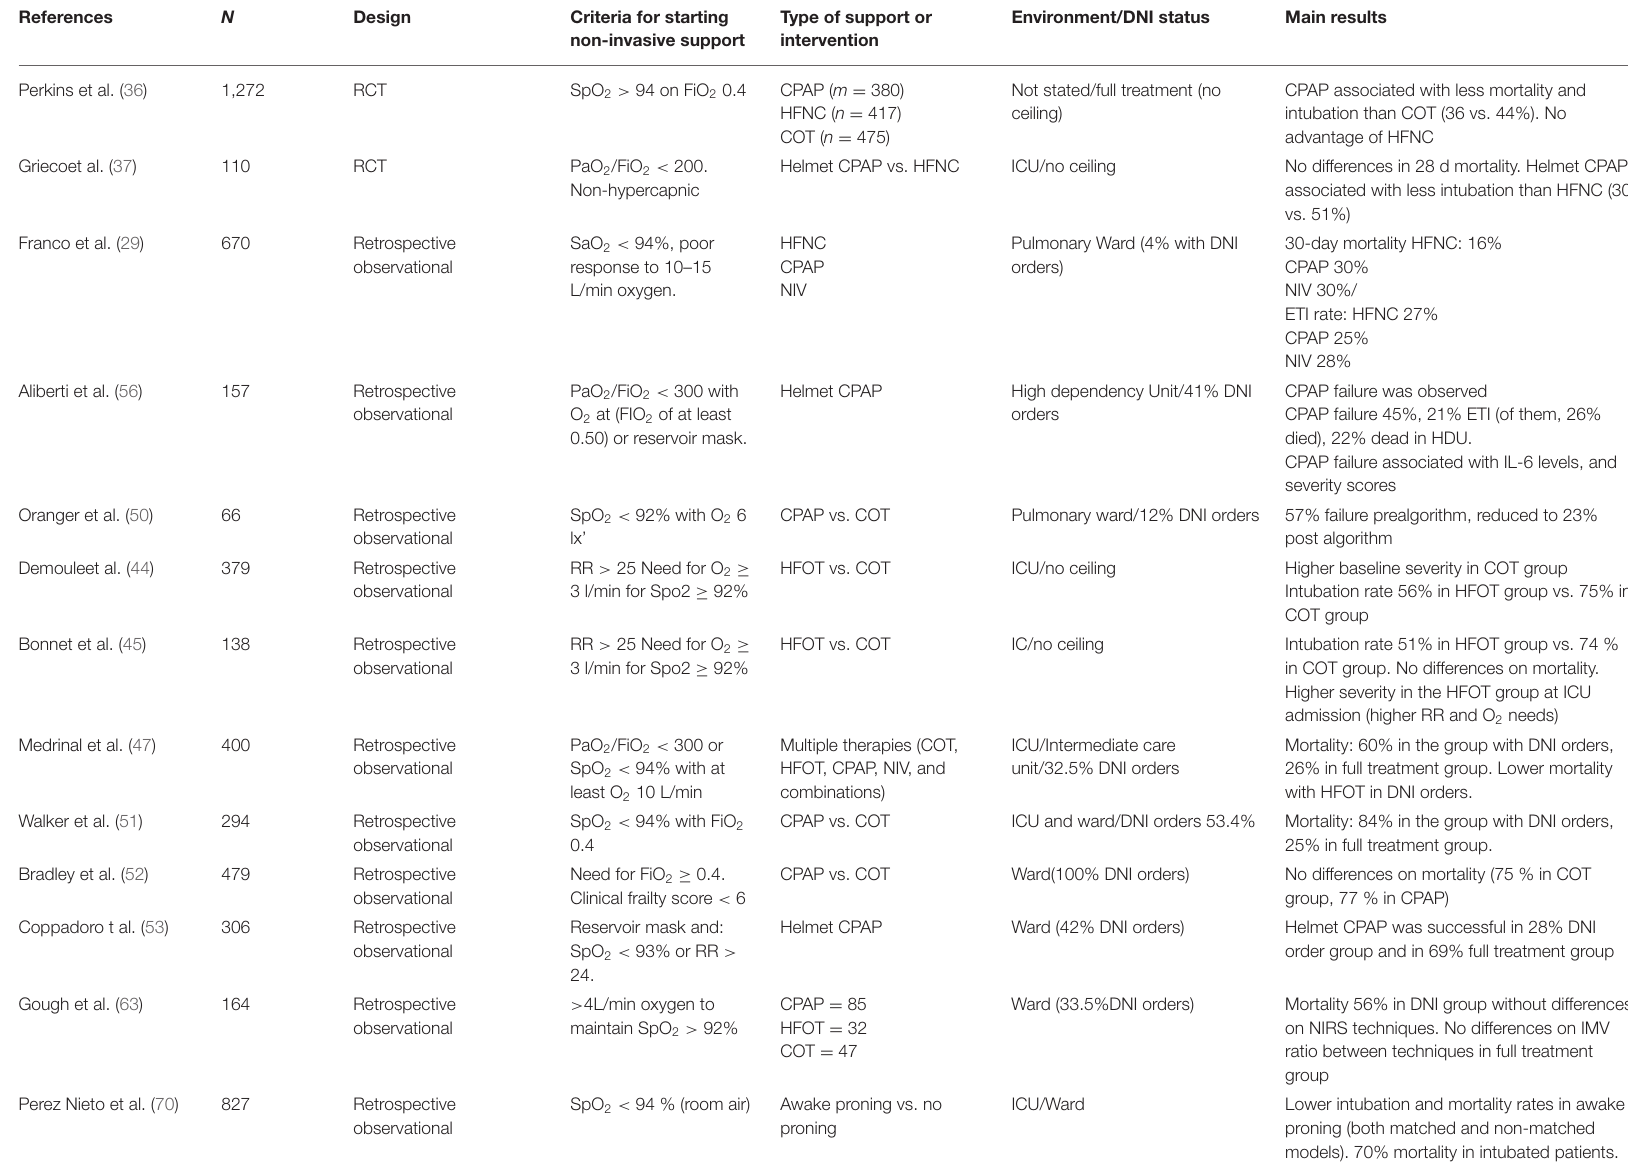
TABLE 1 | Summary of the main studies about NIRS, with emphasis in the NIRS starting criteria, type of support, and main